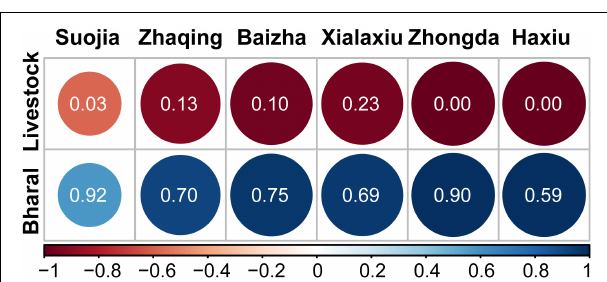
FIGURE 4 | Snow leopard selectivity of livestock and bharal at six sampling sites. Jacobs’ prey selectivity index ( D ), which can vary from − 1 to 1, was calculated based on relative read abundances (shown in the circles) in the snow leopard diets and the population densities of livestock and bharal at six sampling sites. There were no bharal density data from Angsai, so that site was excluded from this analysis. Circle color and size indicate the value of D for the two prey types at each